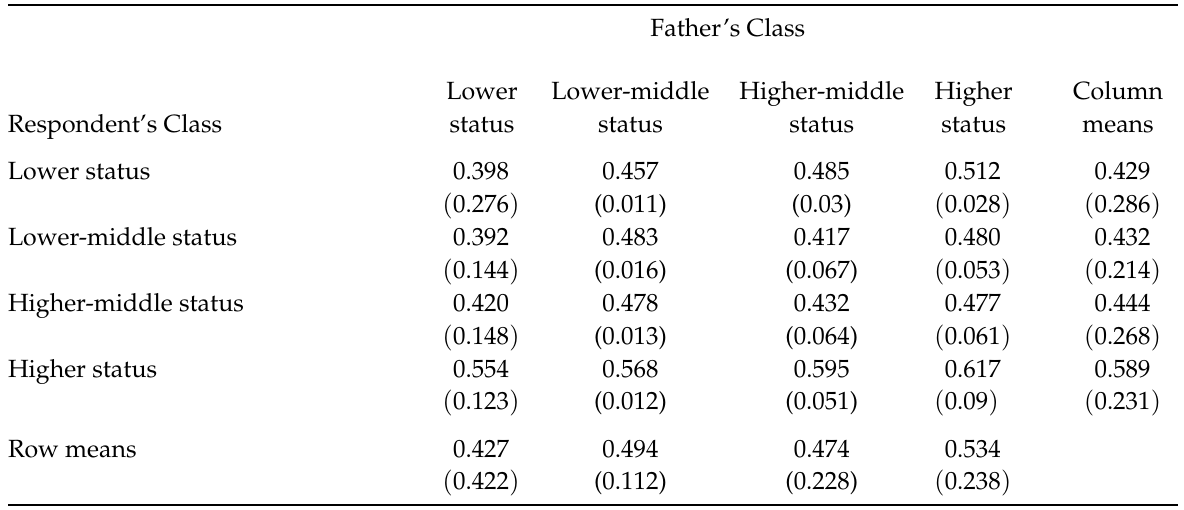
Table 3: Mean happiness levels by father’s and current social status.